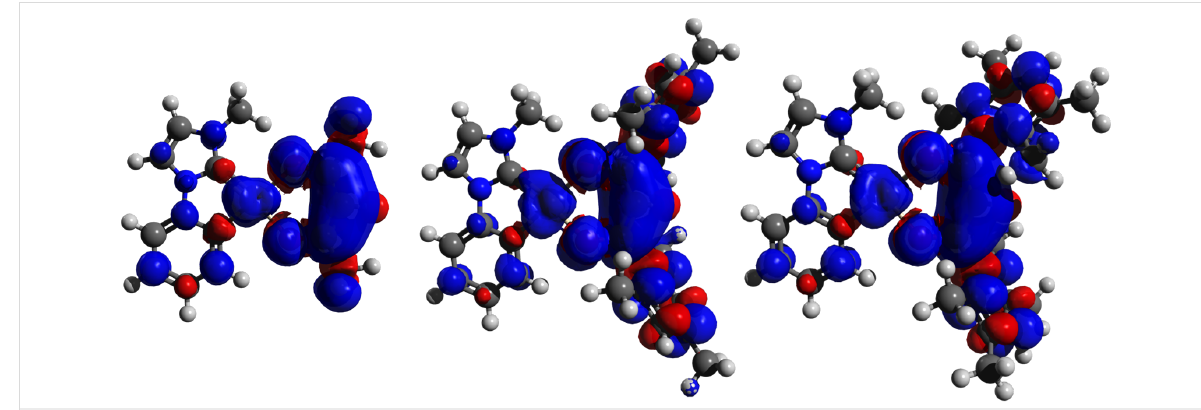
Figure 7: Localization of spin density on the complexes Pt(MPIM)(acac) left, Pt(MPIM)(mes) ( 2 ) middle, and Pt(MPIM)(dur) ( 3 ) right (B3LYP/6- 31G(d), ECP LANL2DZ, isovalue 0.02).